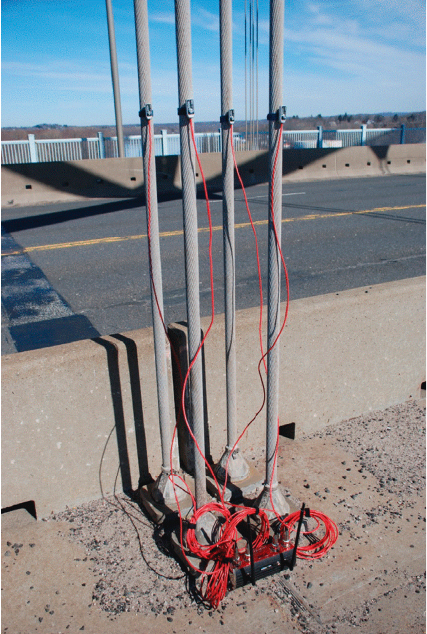
Figure 11: Four accelerometers of the STS-WiFi system used on Arrigoni Bridge.